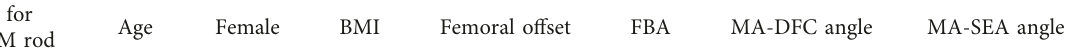
Table 2: Correlations between assessed variables.